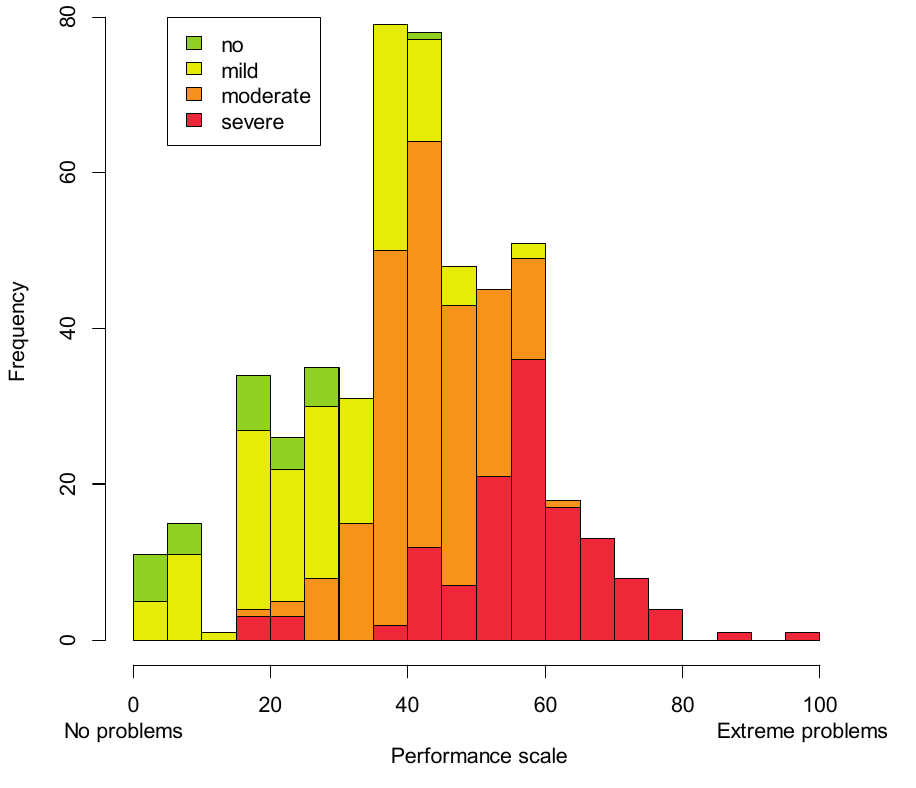
Figure 4. Distribution of the sample on the performance scale; groups generated with the WRD